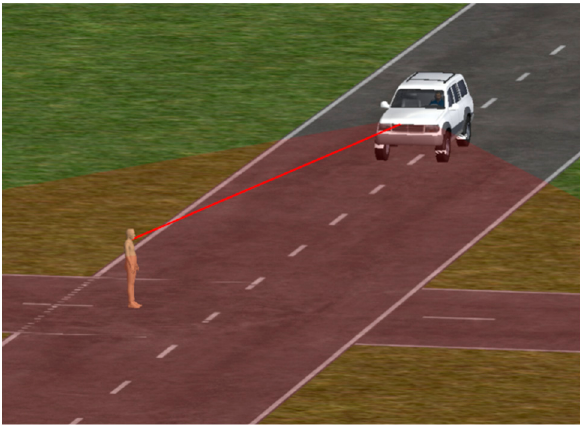
Figure 24. The AEB ‐ P system pedestrian test scenarios. Figure 24. The AEB-P system pedestrian test